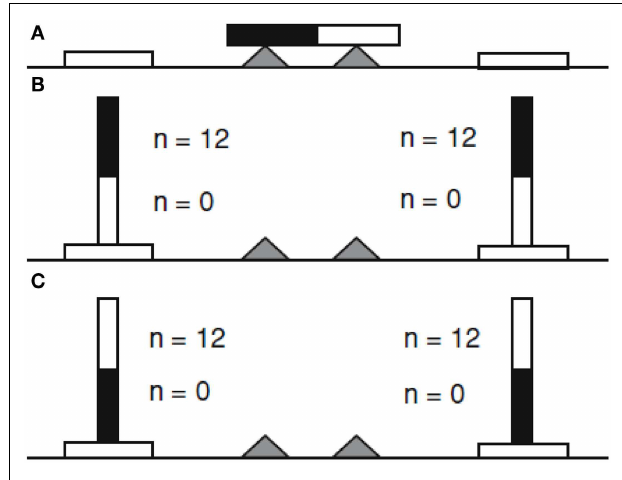
FIGURE 3 | Dowel task transport (Rosenbaum et al., 1990) demonstrating the end-state comfort effect . In (A) , the black and white dowel rests on a cradle with a target on either side of the cradle. In (B) the dowel’s black end was to be placed in the left or right target. In (C) , the dowel’s white end was to be placed in the left or right target.The numbers near the black and white ends of the dowel represent the number of participants who grasped the dowel with the thumb directed toward that colored end of the dowel. (Image from Rosenbaum et al.,